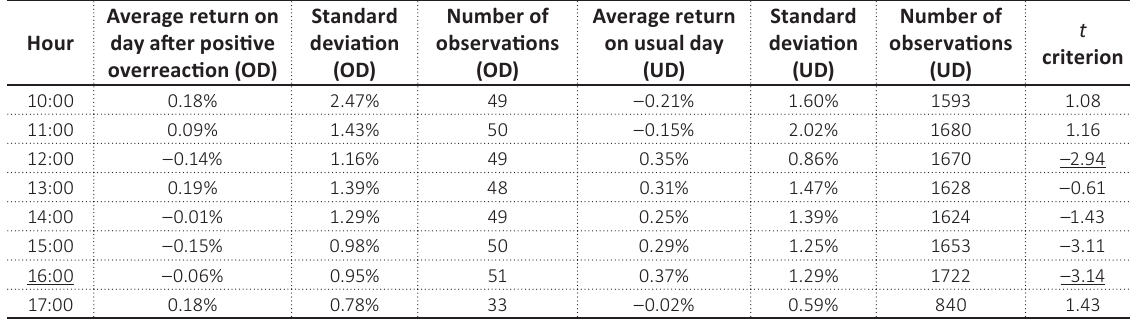
Table 5. T -test of hourly returns on the day after the overreaction and normal days: case of positive overreactions, UX-C